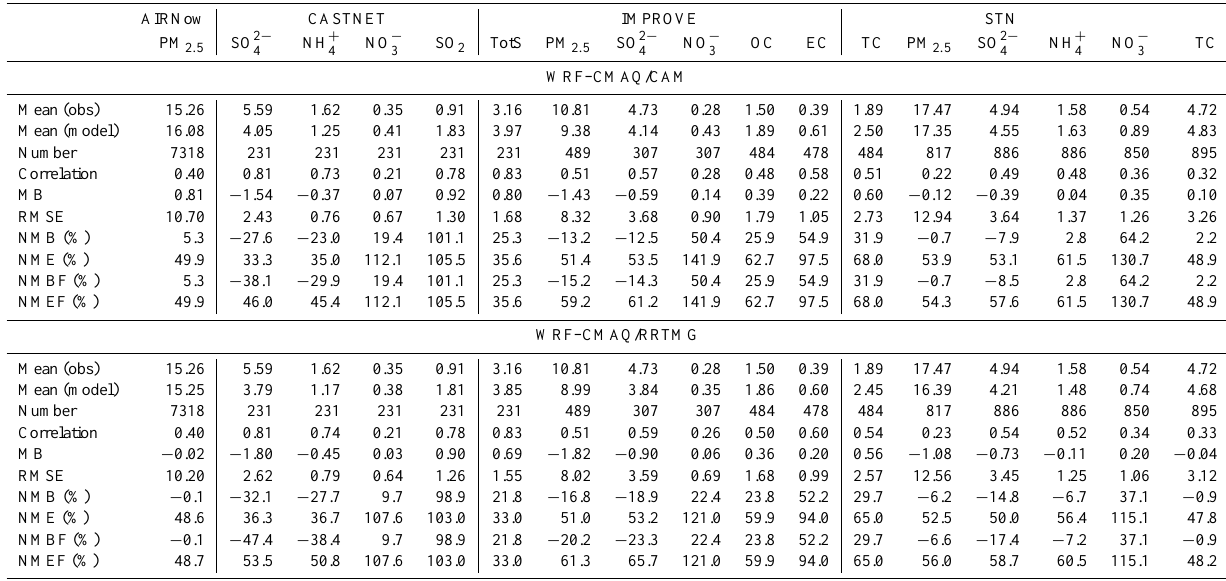
Table 5a. Comparison of observation and models (WRF–CMAQ/CAM and WRF–CMAQ/RRTMG) for PM 2 . 5 and its components for each network over the eastern United States (longitude greater than − 100 ◦ ) for August of 2006 ∗ .